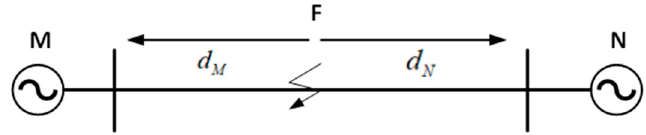
Figure 1. Diagram of traditional fault location.